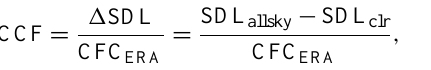
from the Fig. 11. Temporal average of the cloud correction factor (CCF) [W